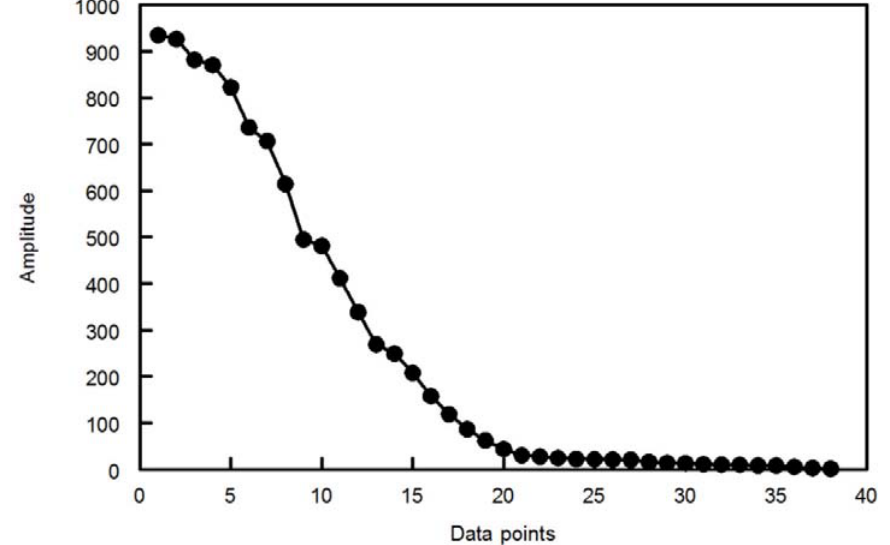
Figure 8. Plot of the absolute values of coefficient vector sorted by magnitude obtained by applying DWT to the simulated signal.